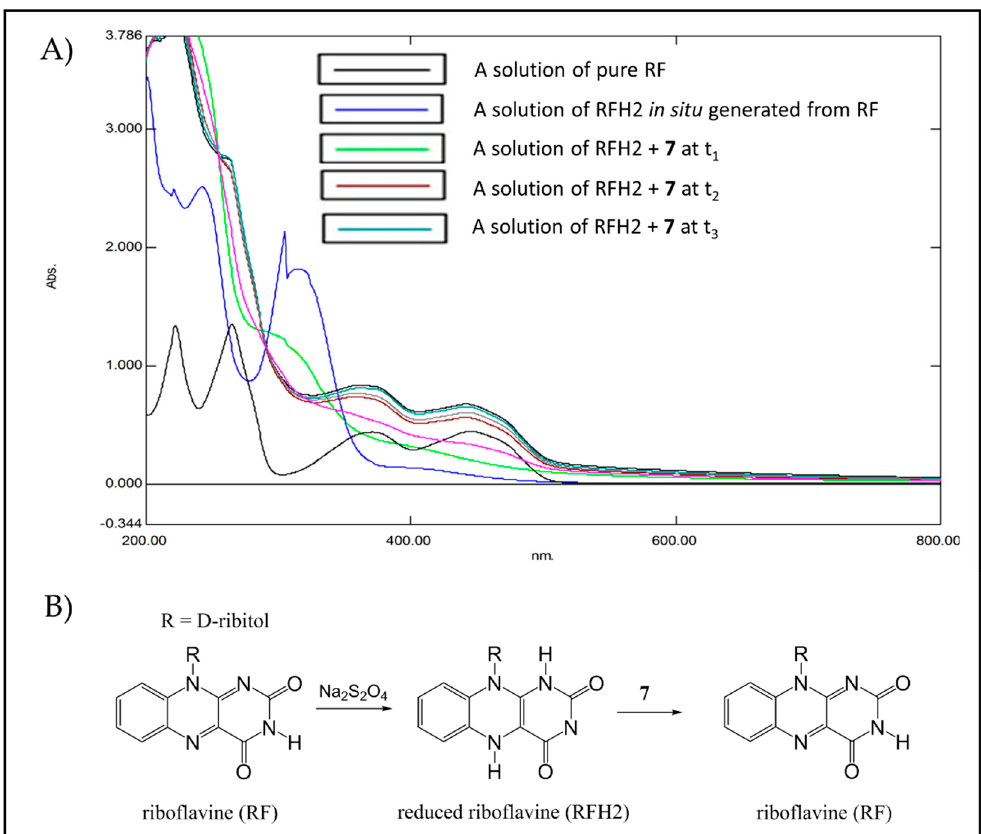
Figure 7. ( A ) UV-Vis analysis of oxidation of reduced riboflavin (RFH2) by trioxane 7 . RF (6.6 × 10 − 4 mmol) was completely converted to RFH2 (disappearance of absorption bands at 370 and 445 nm) by the treatment with sodium dithionite (1.4 × 10 − 4 mmol) under argon at 37 °C. Trioxane 7 (4 × 10 − 4 mmol) in MeCN was added, and the absorptions of the mixture at 370 and 445 nm were monitored at an interval (t 1 –t 3 ) of 20 s until complete oxidation of RFH2 back to RF (within 10 min). ( B ) Proposed mechanism of the in situ generation of RFH2 from RF and the oxidation of RFH2 by 7 to regenerate RF.